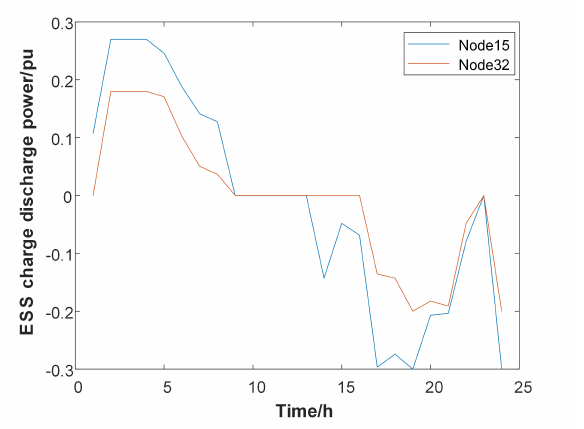
Fig. 7. Energy storage charge-discharge